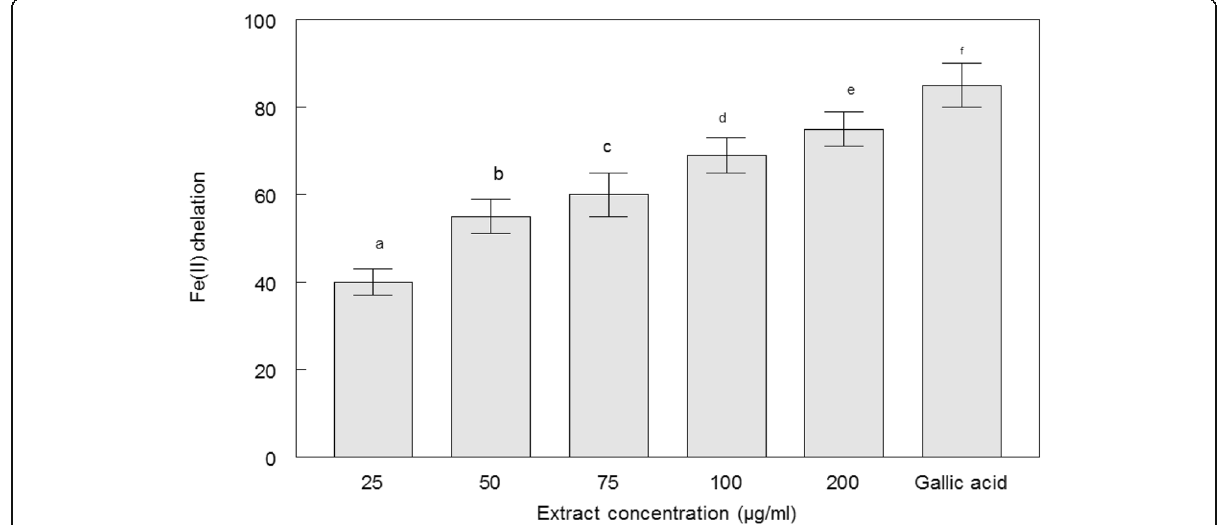
Fig. 4 Iron chelating abilities of Terminalia chebula fruit extract. Gallic acid at concentration of 50 μ g/ml. Values are means±SD ( n = 3). Values in figures which share different letters are significantly ( p < 0.05) different from each other by